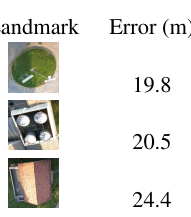
Table 2. Autolocalization error compared with the UAV GPS